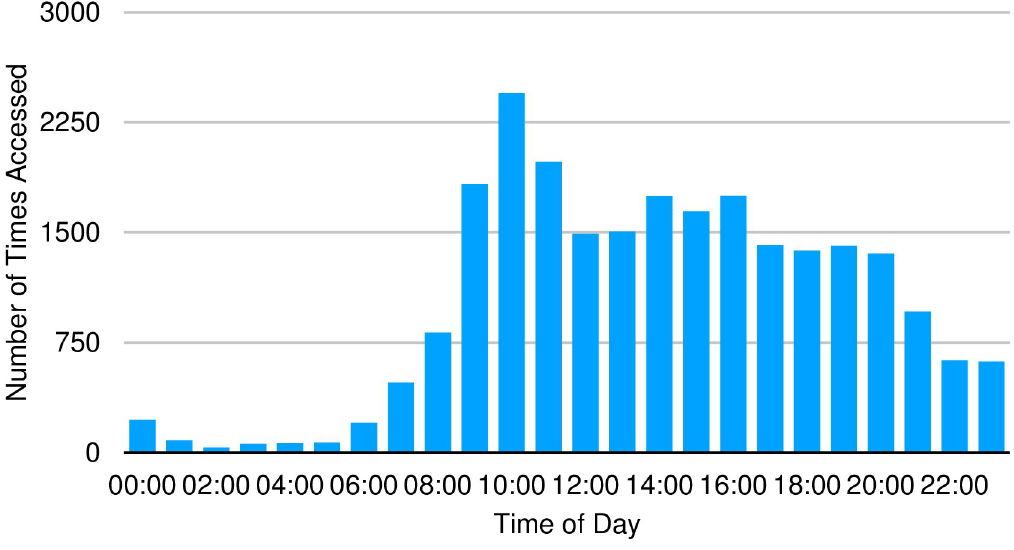
Fig 3. Number of accesses to the ODP across the